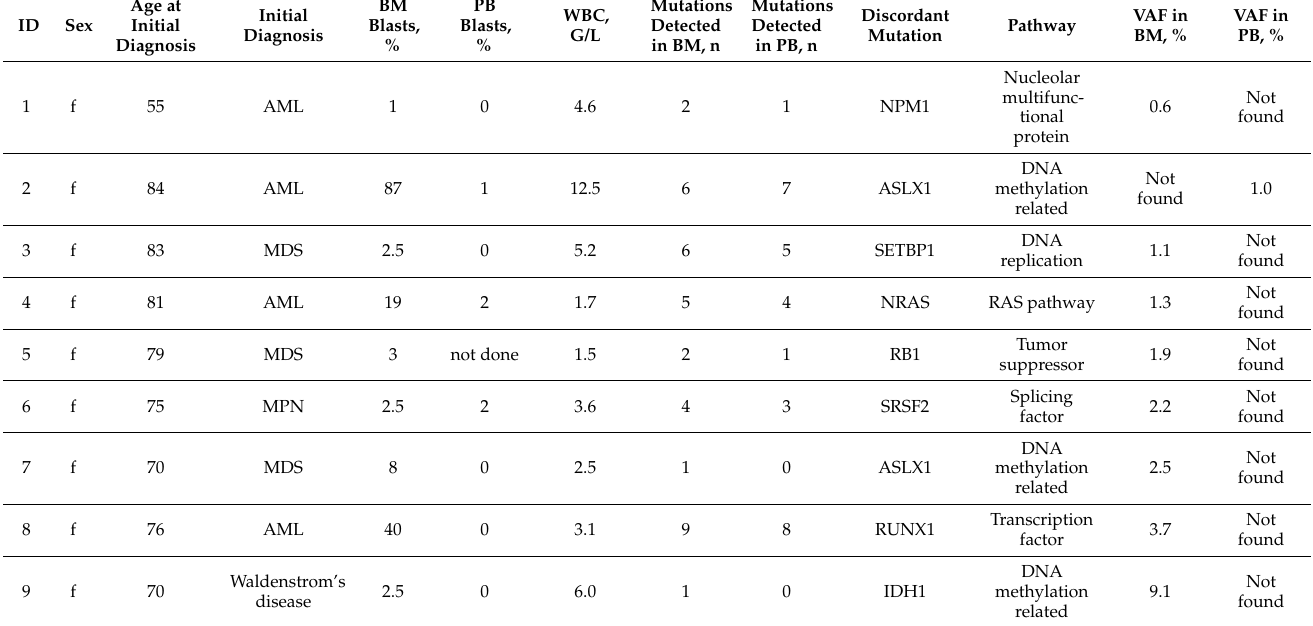
Table 4. Discordant samples (n = 9): mutations found in only one of the paired samples (i.e., either in the peripheral blood but not in the bone marrow, or vice